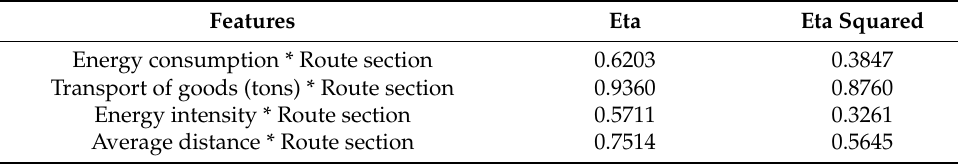
Table 6. Measures of association.